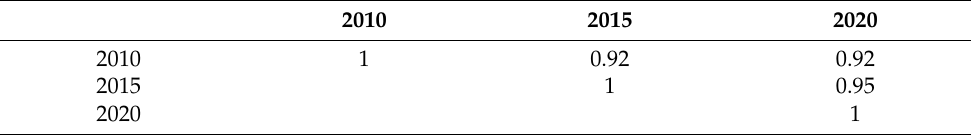
Table 3. Rank order correlations (Spearman’s rho) between the SI country rankings.